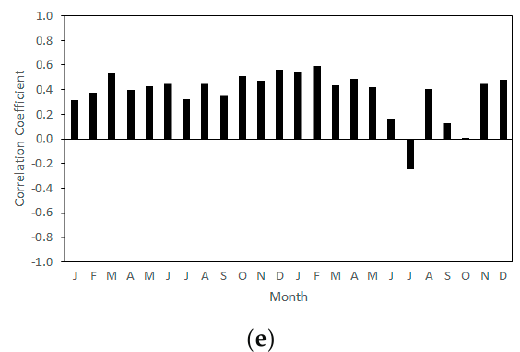
Figure 5. Temporal variation of linear correlation between O 3 concentrations and the following: ( a ) NO concentrations, ( b ) temperature, ( c ) NO 2 concentrations, ( d ) relative humidity, and ( e ) wind speed.